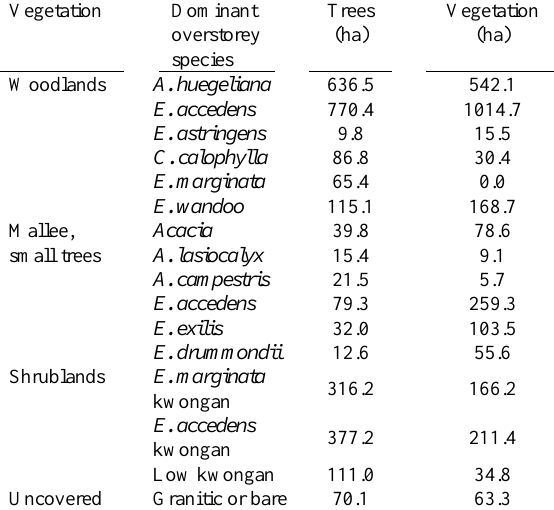
Table 2. Area covered per class within the western part of the Boyagin Nature Reserve for defined classes of tree and vegetation objects.